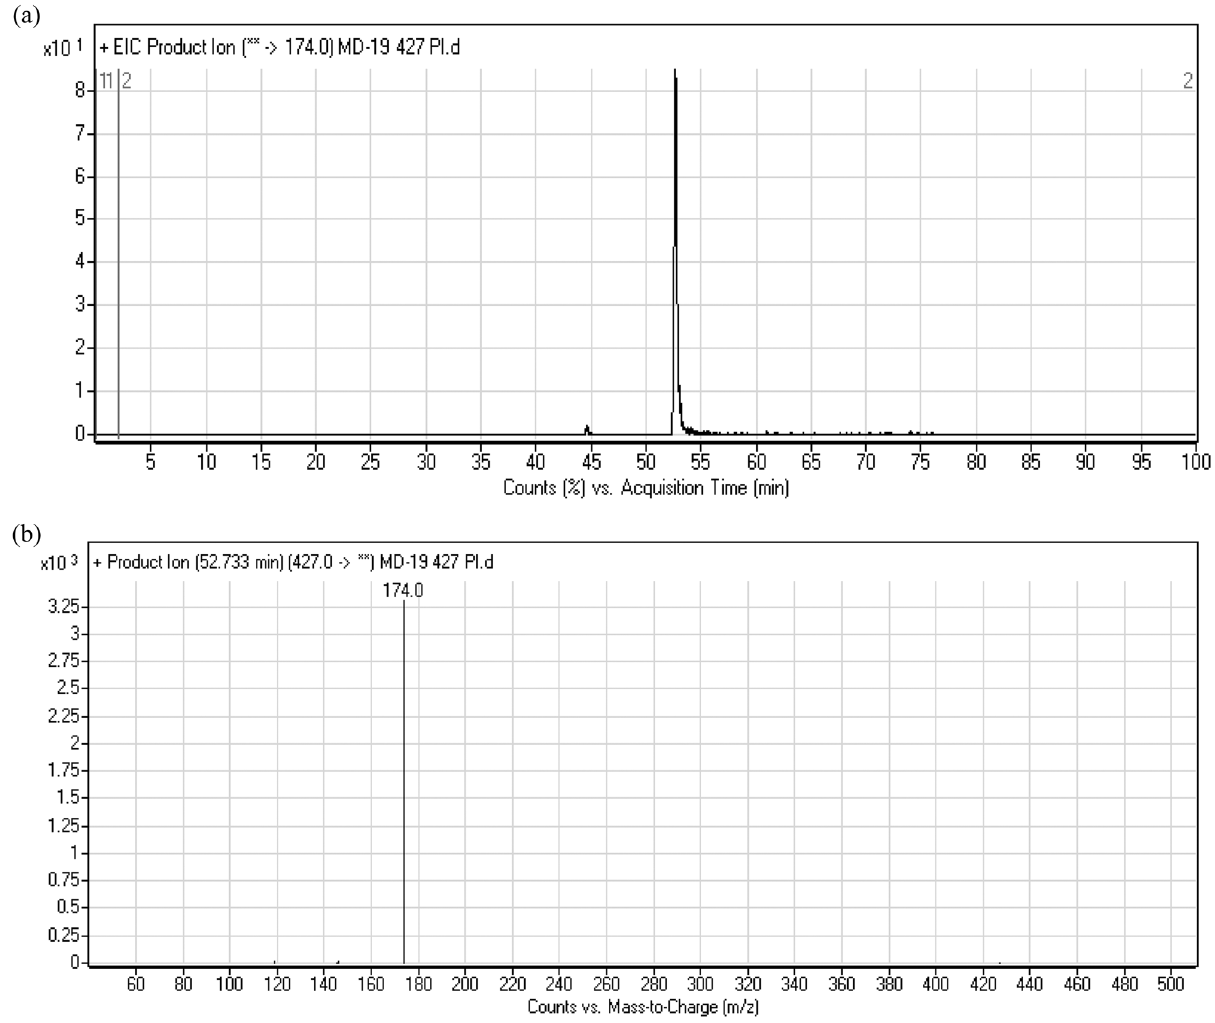
Figure 4: PI chromatogram of compound 1 showing a chromatographic peak at 52.7 min ( a ) and PI mass spectrum of compound 1 ( b ) . ( PI fragmentation of compound 1 at m / z 427 gave one fragment ion at m / z 174 that represented the breakage of the carbohydrazide bond.